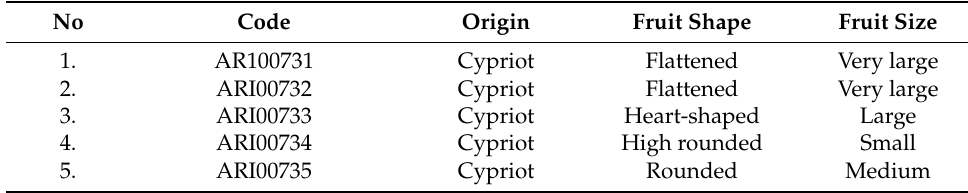
Table 1. Tomato genotypes used in the current